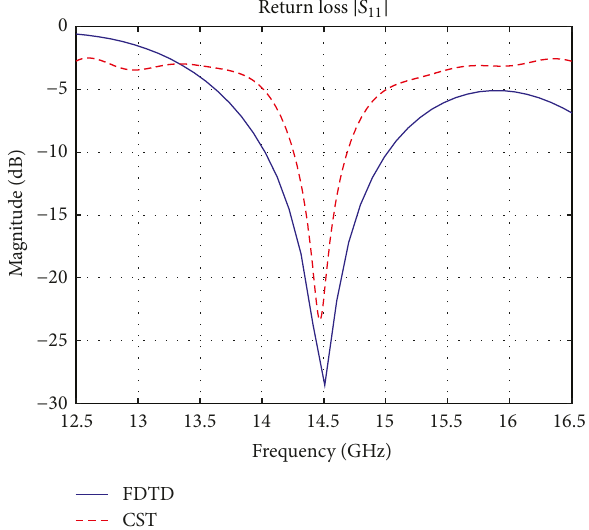
Figure 8: Simulated results for the return loss of a rectangular patch antenna with CST and the developed simulator.